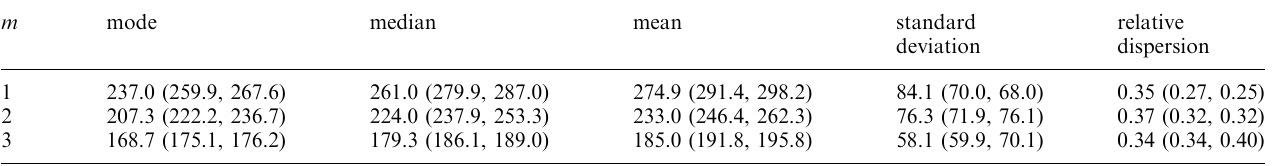
Table 4. Statistical characteristics of the three largest daily aa indices per solar cycle (in nanoteslas) for solar cycles 9 to 22. Pairs of numbers in parentheses are the corresponding values for solar